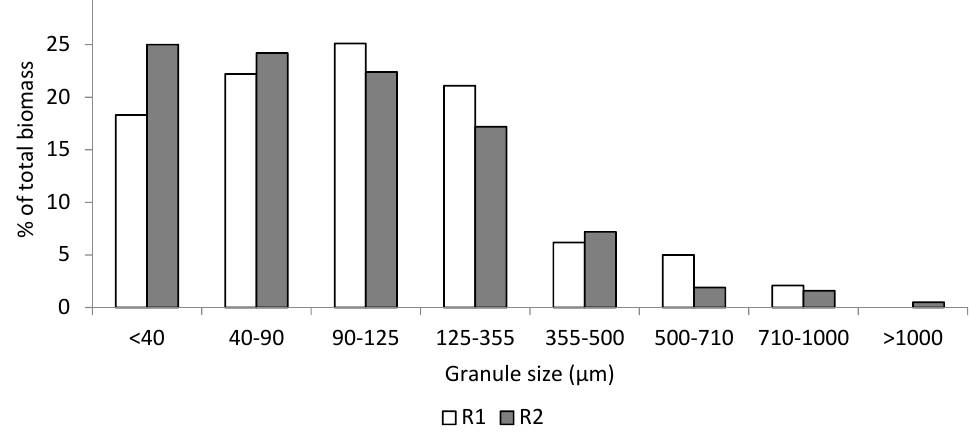
Figure 2. The distribution of granule particle sizes in the batch reactors.